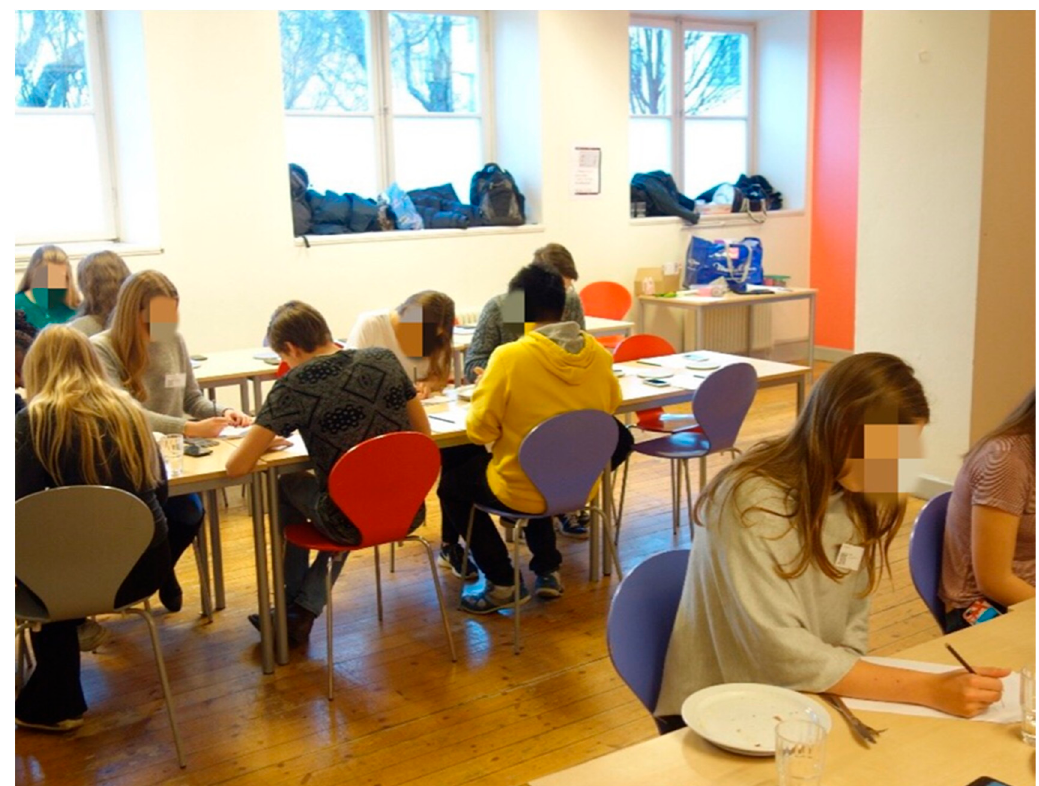
Figure 1. The lunchroom where the participating students ate their lunches.